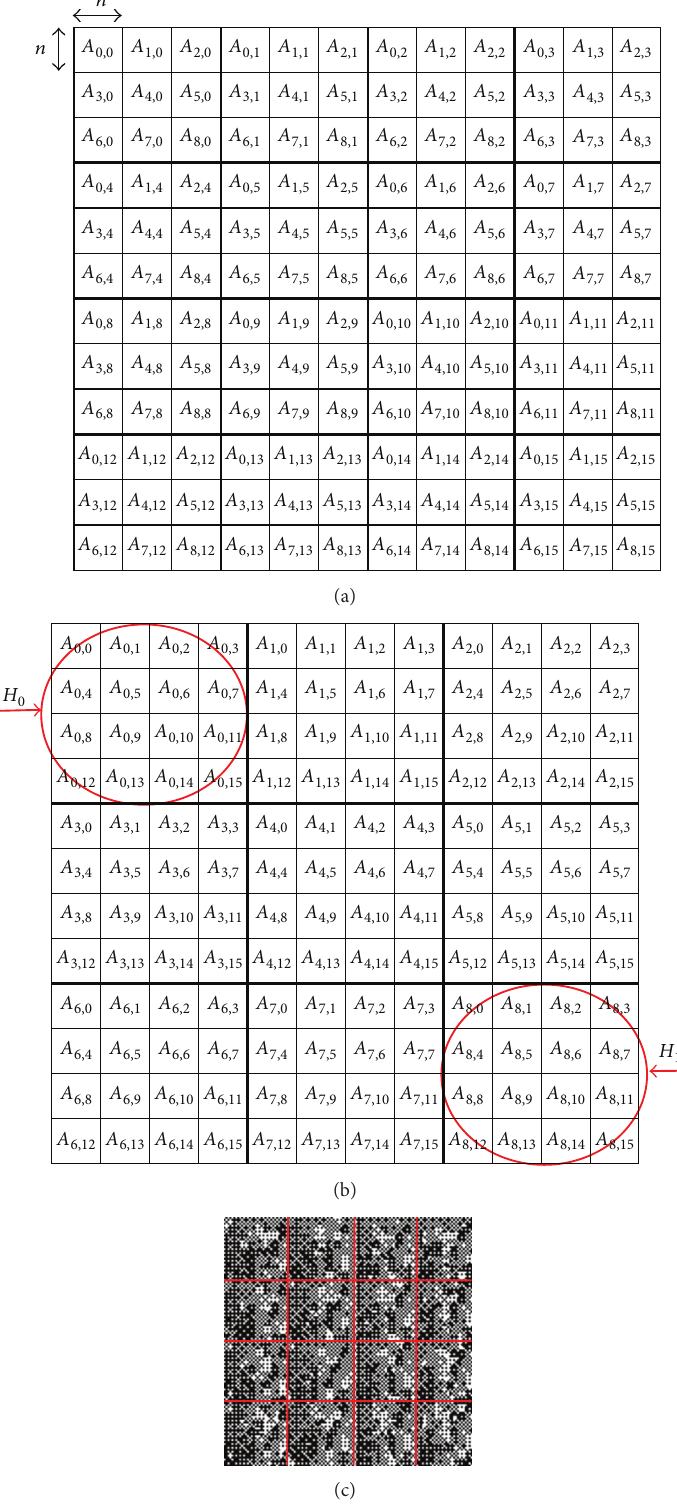
Figure 4: An example of subimage segmentation. (a) An image divided into 3 × 3 blocks, each of which has 4 × 4 subblocks. (b) The segmentation result of (a). (c) The segmentation result of Figure